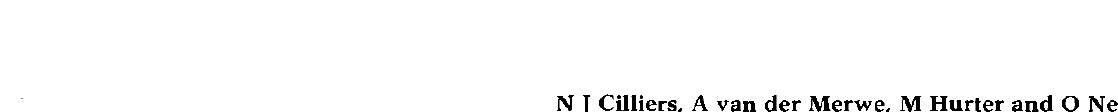
Table 4: Percentage of subjects and ears with absent and present acoustic reflexes Percentage of Percentage of ears subjects Acoustic reflexes present 48% 29% Acoustic reflexes absent